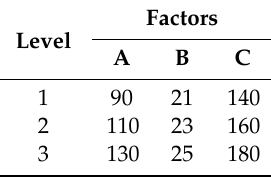
Table 1. L 9 (3 4 ) orthogonal factors and levels of extrusion. Level